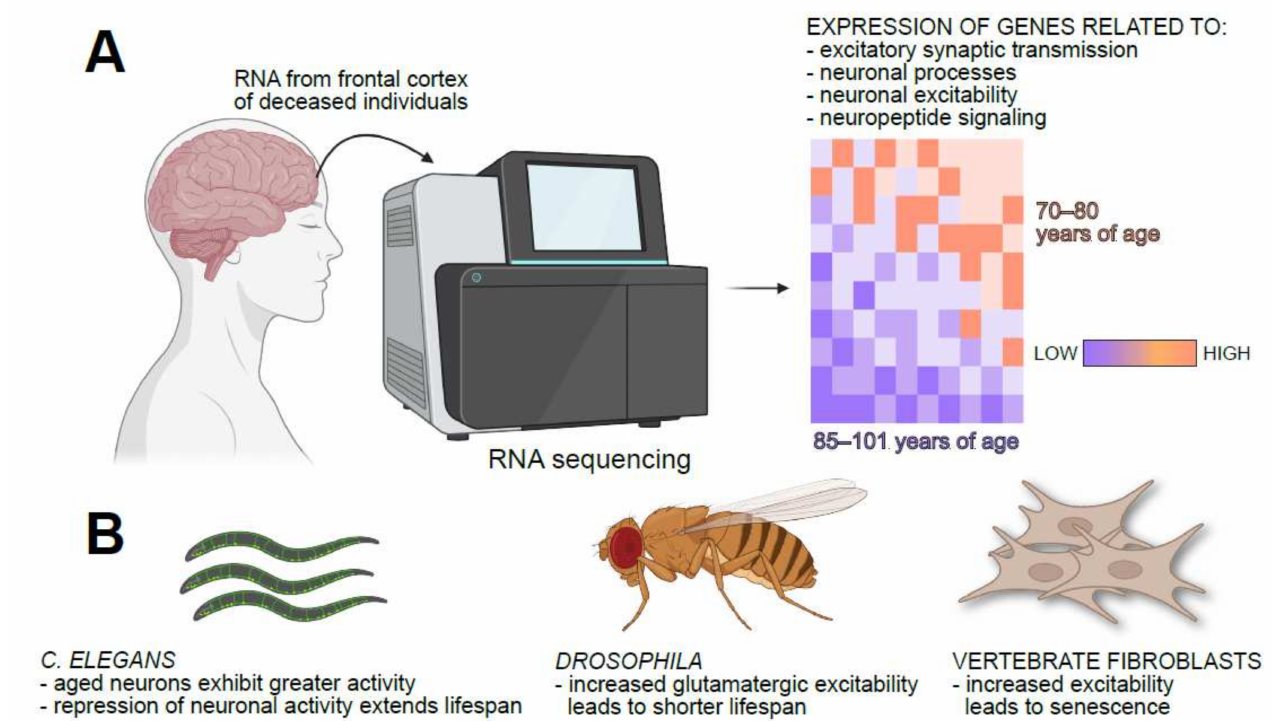
Figure 1. Regulation of cellular and organismal aging by neuronal excitability. ( A ) Sequencing of RNA extracted from the frontal cortices of deceased individuals revealed that expression of genes related to neuronal excitability and excitatory synaptic transmission was relatively lower in long-lived humans (i.e., those who died between the ages of 85–101 years) compared to that in people who died between the ages of 70–80 years. ( B ) In both C. elegans and Drosophila , neuronal excitability is inversely correlated with longevity, and pharmacological repression of neuronal activity extends lifespan. In non-excitable cells such as fibroblasts, increased electrical excitability is associated with precocious onset of senescence. Images created with BioRender.com (accessed on 20 January